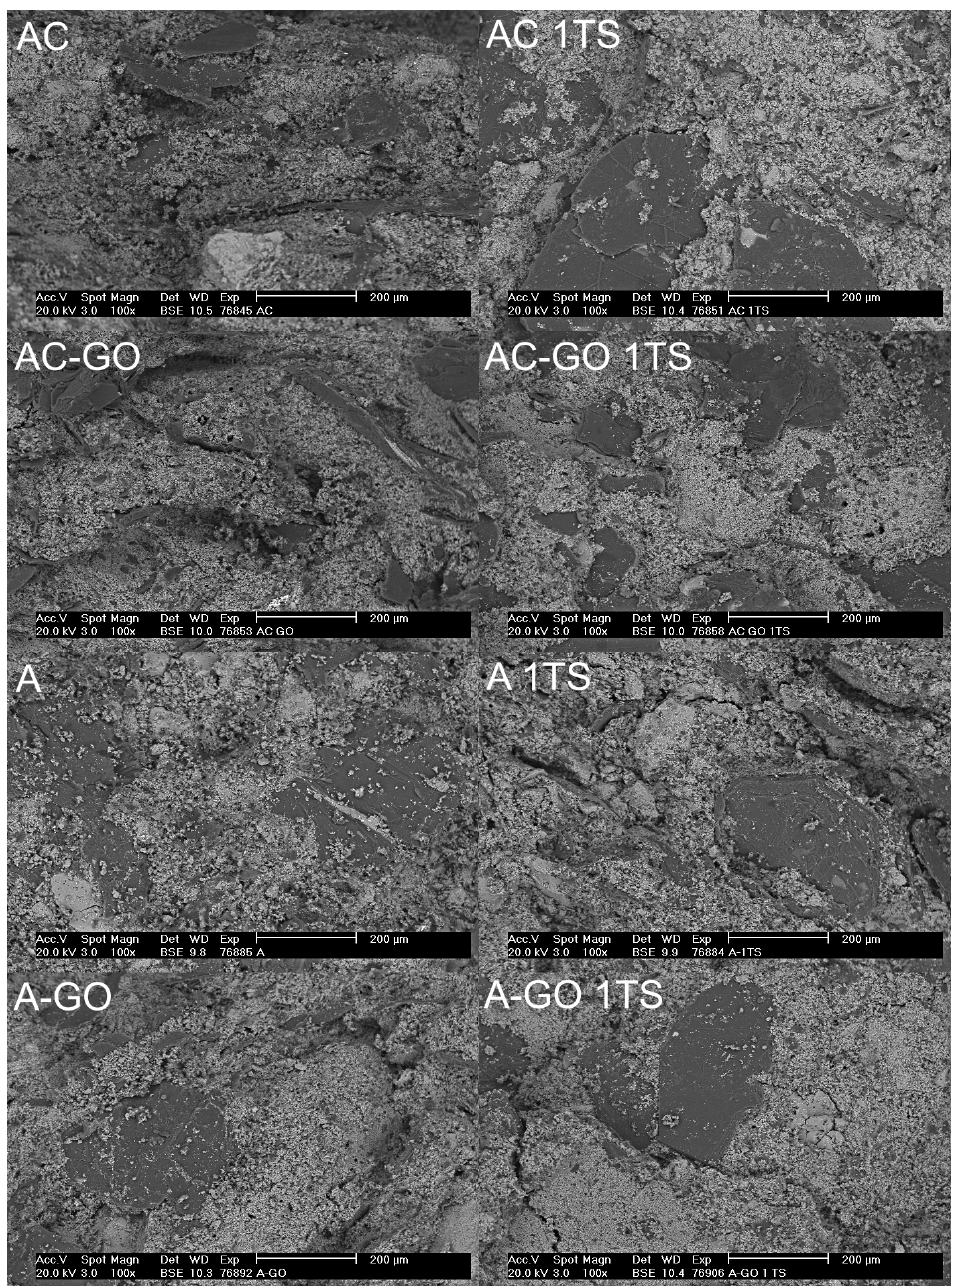
Figure 4. Scanning electron micrographs of the fracture surface of refractory samples, before and after (1TS) one thermal shock cycle. A = graphite not included in the aggregate size distribution calculation; AC = graphite included in calculation; and –GO = coarse alumina coated with graphene